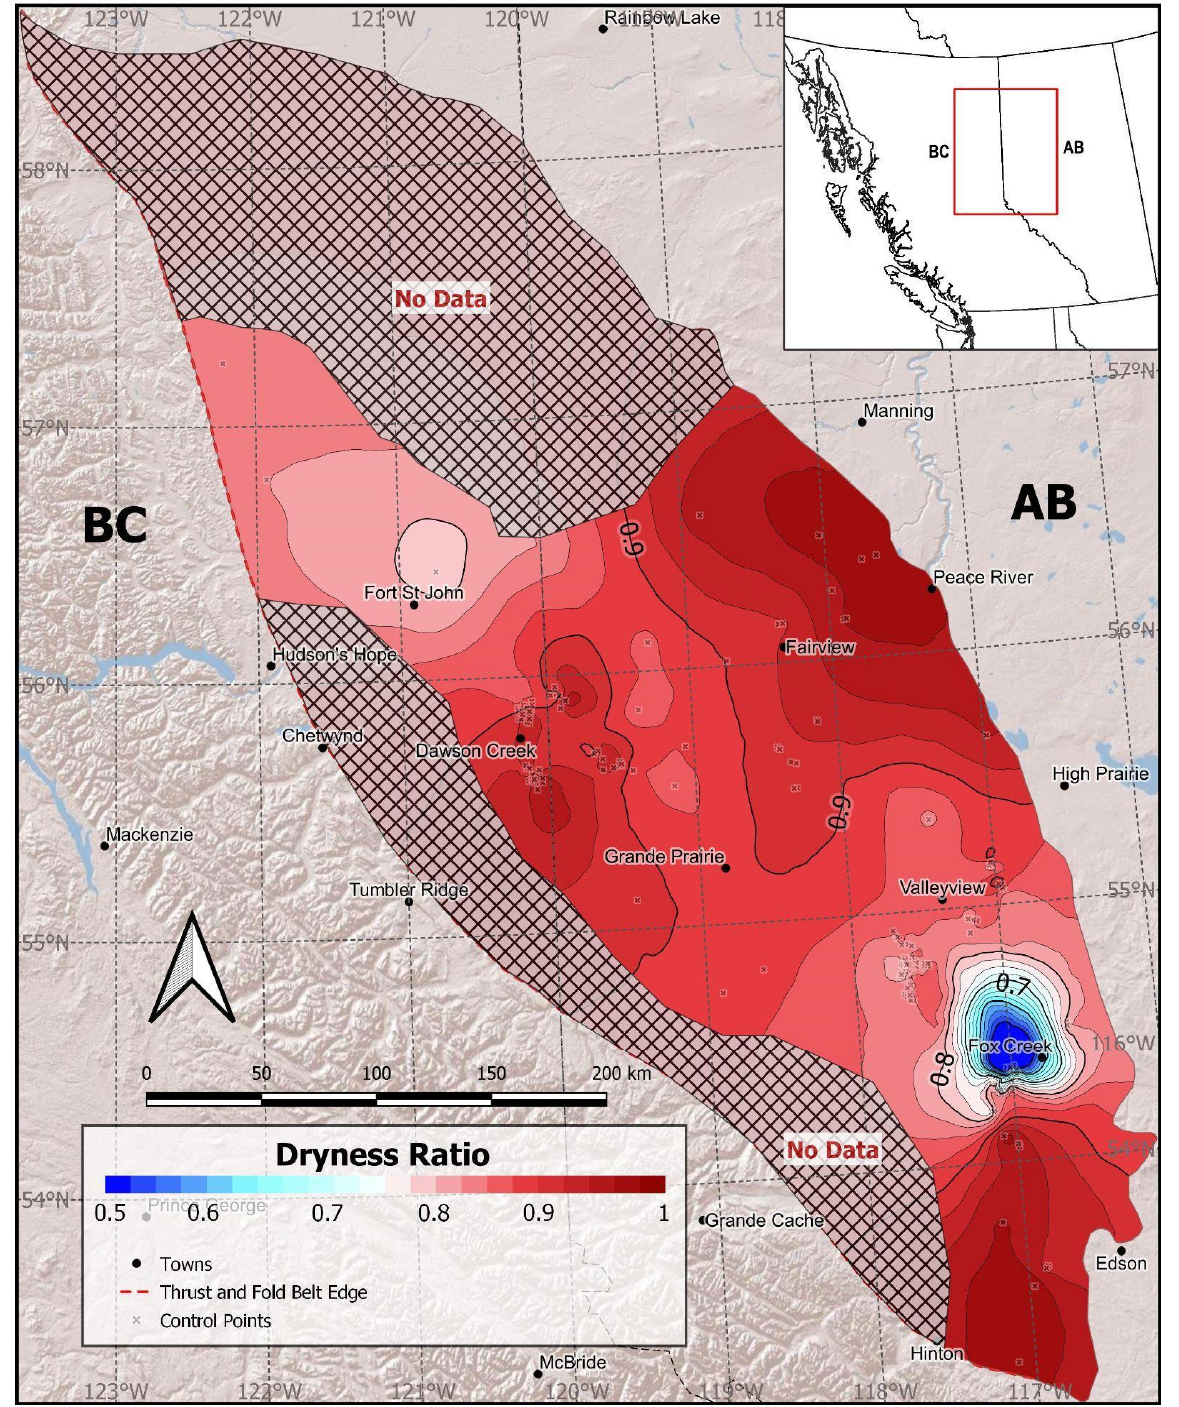
Figure 27. The distribution of the gas dryness ratio on the Upper Montney Formation. The gas wetness increases in the Upper Montney Formation near Fox Creek, Alberta, compared to the Middle (Figure 26) and Lower (Figure 25) Montney subunits.